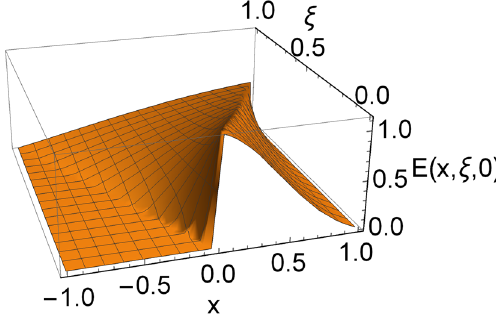
Fig. 4 Kaon tensor GPD E u ( x ,ξ, 0 ) , because of the symmetry prop- erty in Eq. (27b), we only plot ξ > 0 part